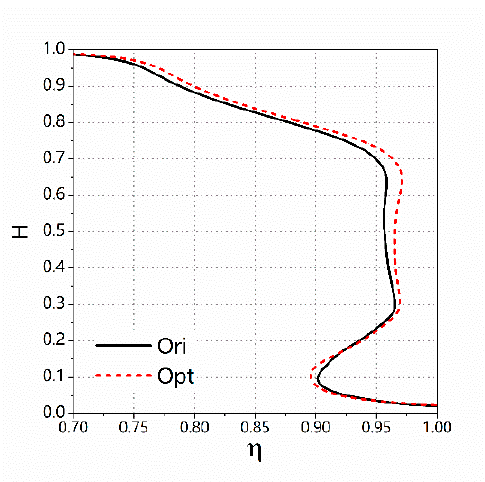
Figure 13. Span-wise adiabatic efficiency of the second-stage rotor of the original and optimized compressor.